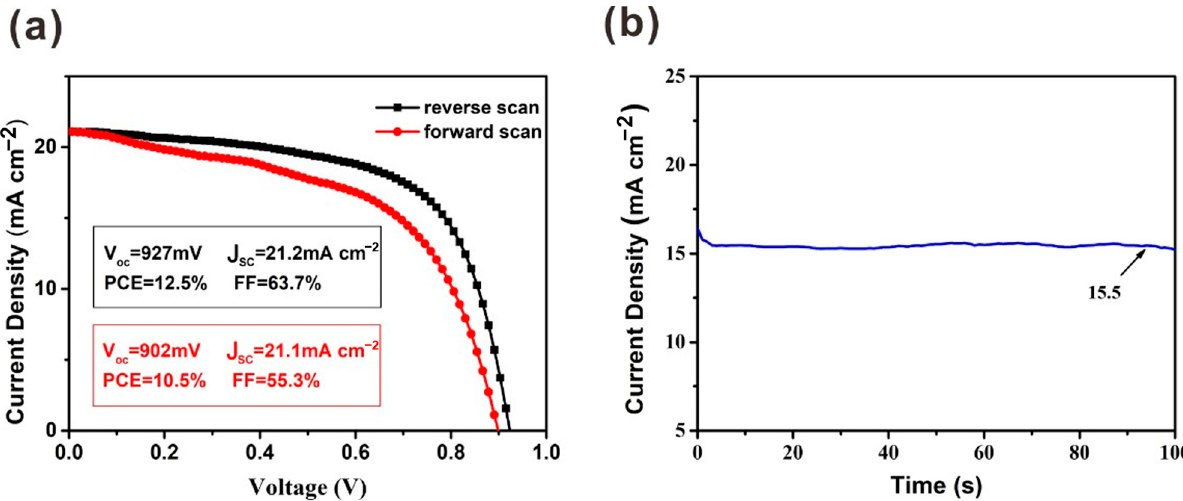
Figure 6. ( a ) J–V curves under reverse scan and forward scan with the preparation of PbI 2 film under